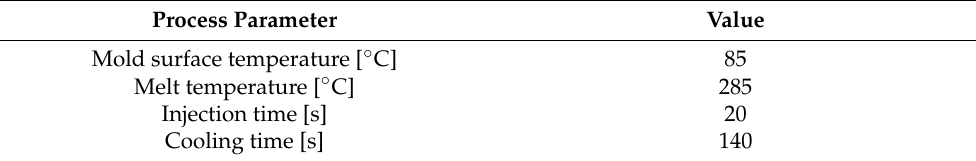
Figure 20. ( a ) Dimensions and configuration of the specimen after cutting, ( b ) FE model and boundary conditions. Table 2. Injection molding process parameters of PA6-20CF composite cross member.